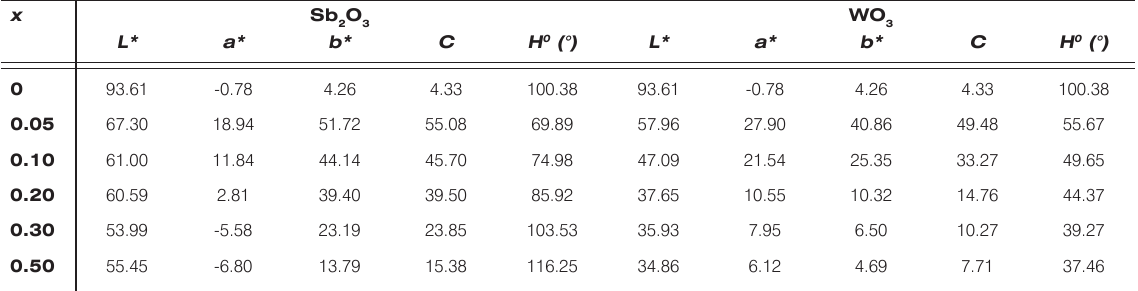
Cr M O prepared at calcination temperature 1050°C. 1-3x x 2x 2